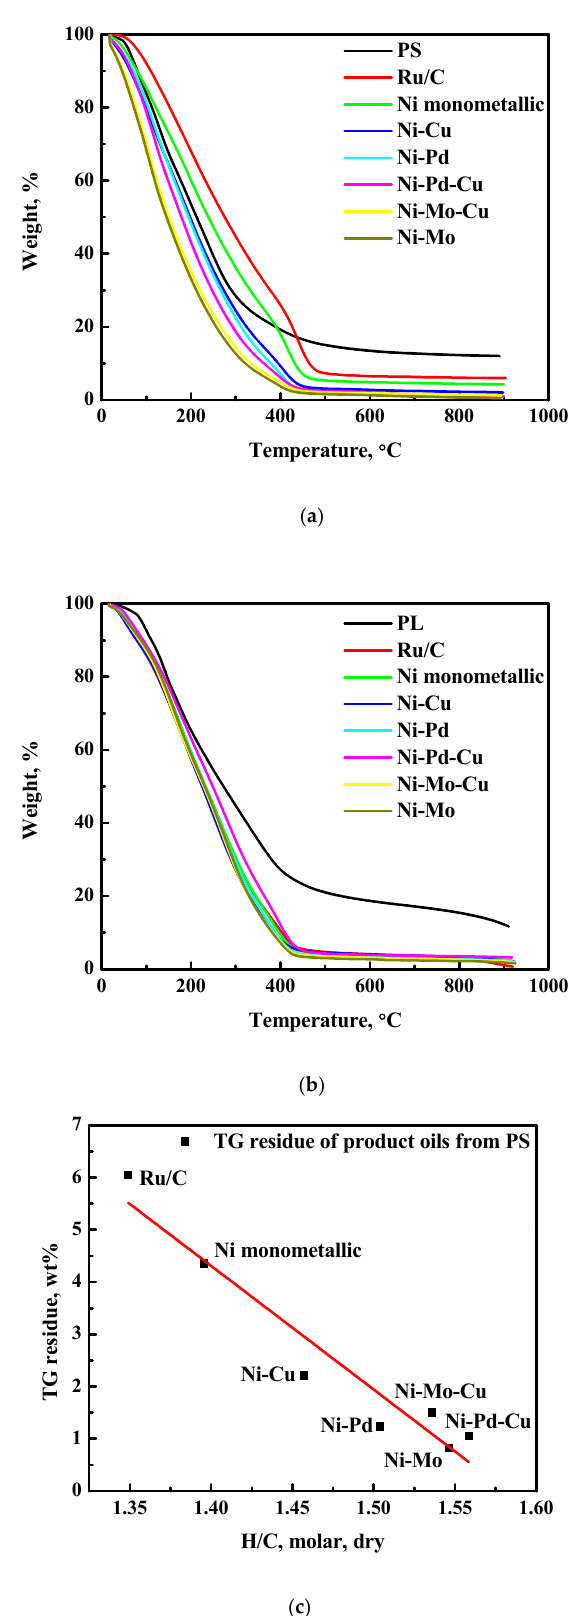
Figure 4. The TG residue of PS, PL feed and hydrogenated oils using nickel-based catalysts and Ru/C by Thermogravimetric Analysis (TGA): ( a ) TGA curves of PS feed and hydrogenated oil products, ( b ) TGA curves of PL feed and hydrogenated oil products, ( c ) TG residue of PS and hydrogenated oil products versus the H/C ratio.